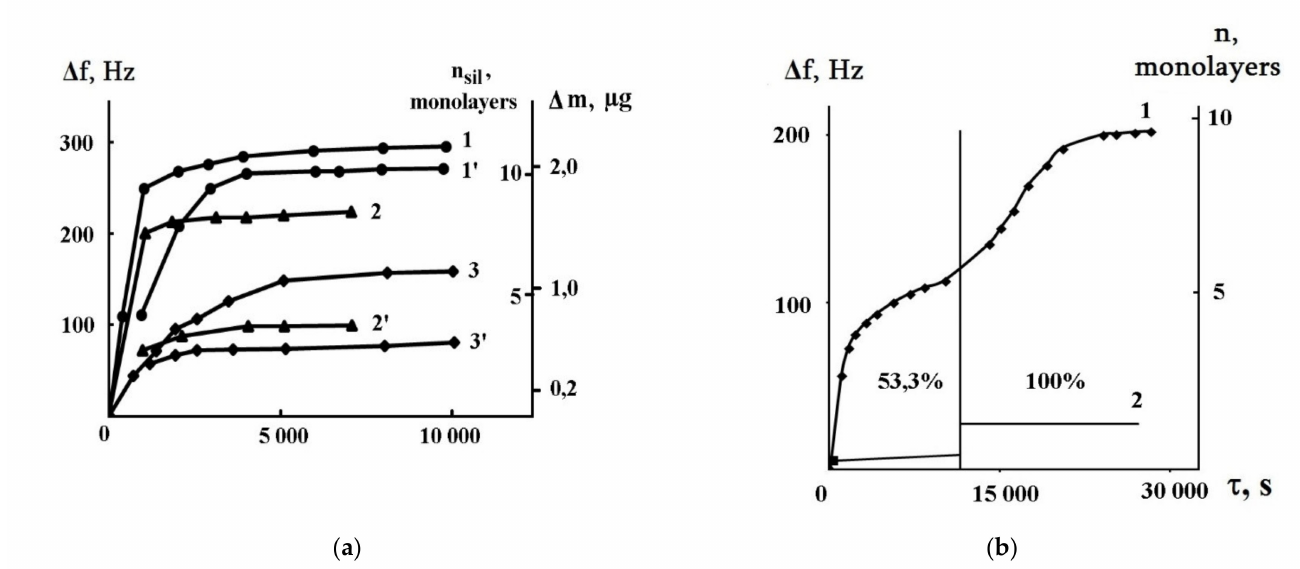
Figure 4. ( a )—Variations of the QCM frequency and mass gain due to irreversible adsorption of BTMS (1,2,3) as a function of the humidity (1—100% RH; 2—71% RH and 3—53.3% RH). 1’, 2’ and 3’ are the changes of frequency and the mass of reversibly adsorbed water. ( b )—monitoring of the frequency and the thickness of MTMS film as a function of Ar humidity [20]. Published with permission from NAUKA/INTERPERIODIKA